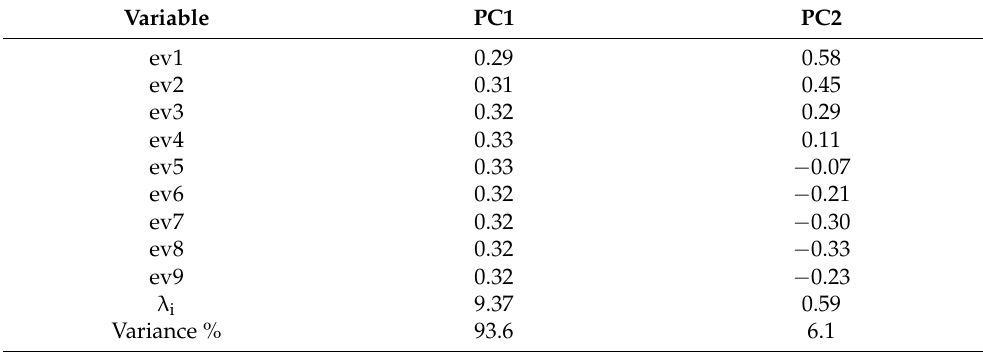
Table 5. Estimated eigenvalues ( λ i ) and eigenvectors (evi) for the principal component analysis results with the genetic values of reproductive efficiency for each calving, from a total of 38,058 animals. Variable PC1 PC2